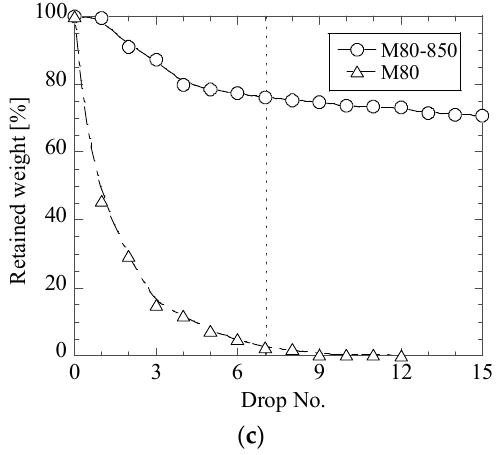
Figure 5. Relationships between retained weight of briquettes M100 ( a ), M90 ( b ) and M80 ( c ) and drop number in drop test trials for mesa briquettes before and after heat treatment at 500 °C and 850 °C.